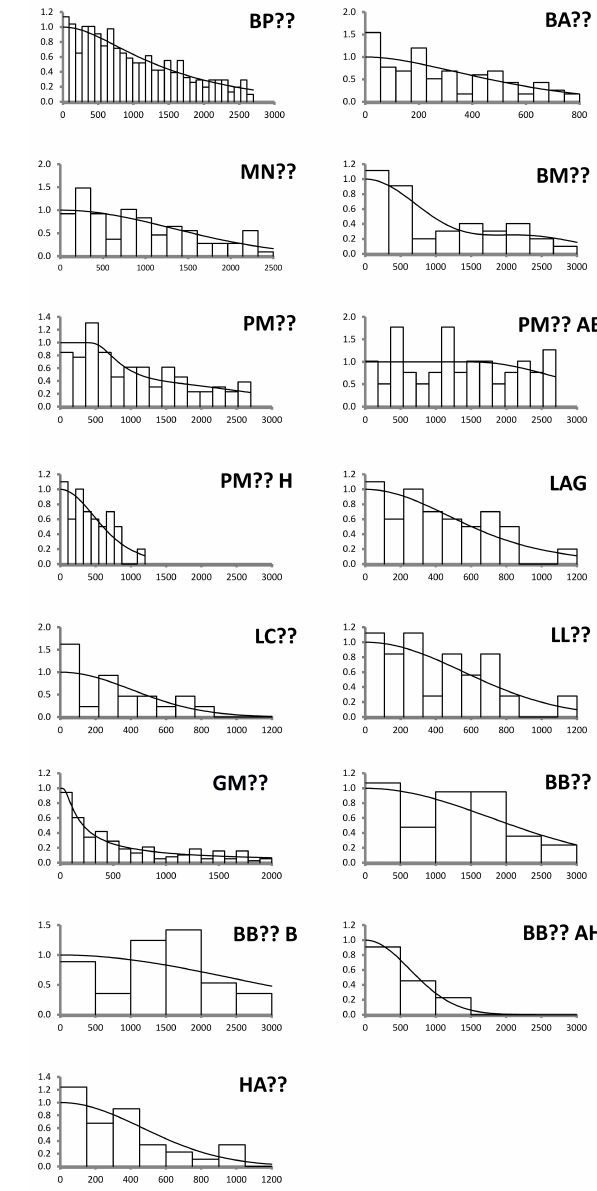
Figure 5. Detection functions. See Table 2 and Figure 2 for species definitions. Vessel codes follow species ID in some cases. LAG – all dolphins of genus Lagenorhynchus . Number of ? indicates least level of confidence in species identification included in the detection function, i.e. no ? = high, ? = medium, ?? = low. Corrected estimate Sightings are specified by vessel and platform in Table 4. On vessel A, the platforms had approximately equal numbers of sightings, and about one third of all sightings were duplicates. On vessel B, platform 1 made 47% more sightings than platform 2, and the proportion of duplicates was slightly lower than that on vessel A. Platform 2 made over twice as many sightings as platform 1 on vessel H, and the proportion of duplicates was lower than on the other 2 vessels. The proportion of duplicates was higher for the higher certainty fin whale identifications on all 3 vessels. Overall the proportion of duplicate sightings was 28% for the ALL species certainty